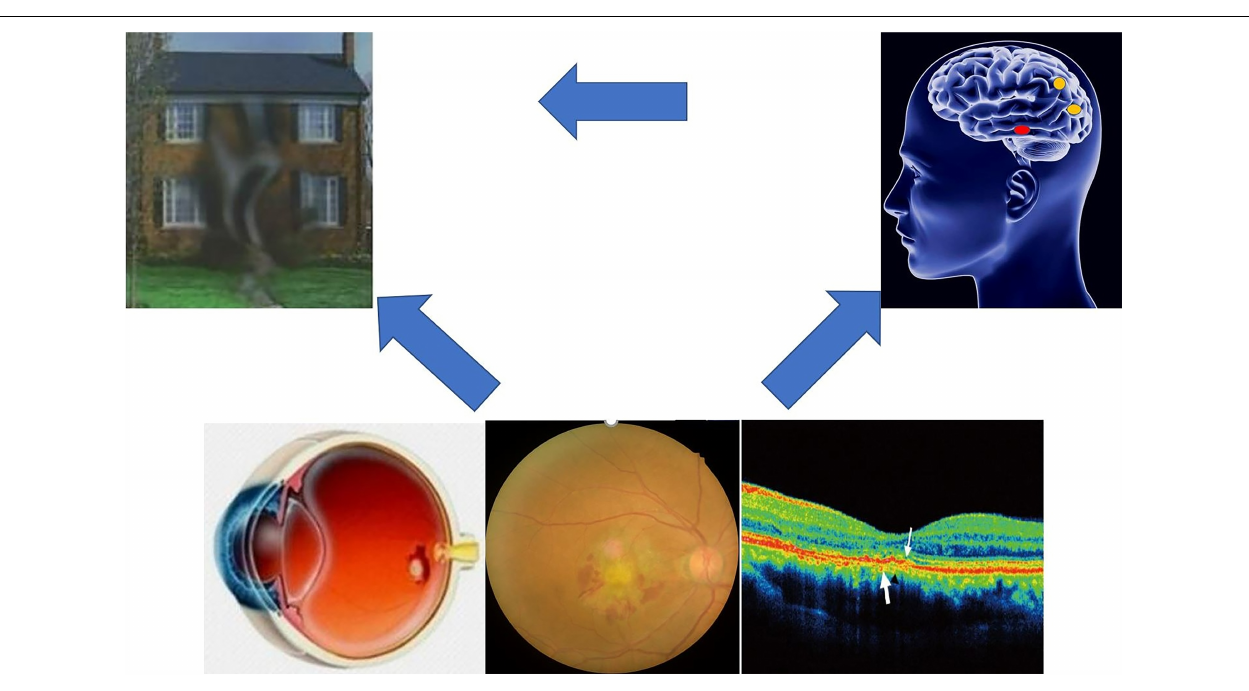
FIGURE 7 | Correlations between AMDs ReHo and behavioral performance, compare with HCs, AMDs may suffer more problems with dealing with emotion, memory and visual